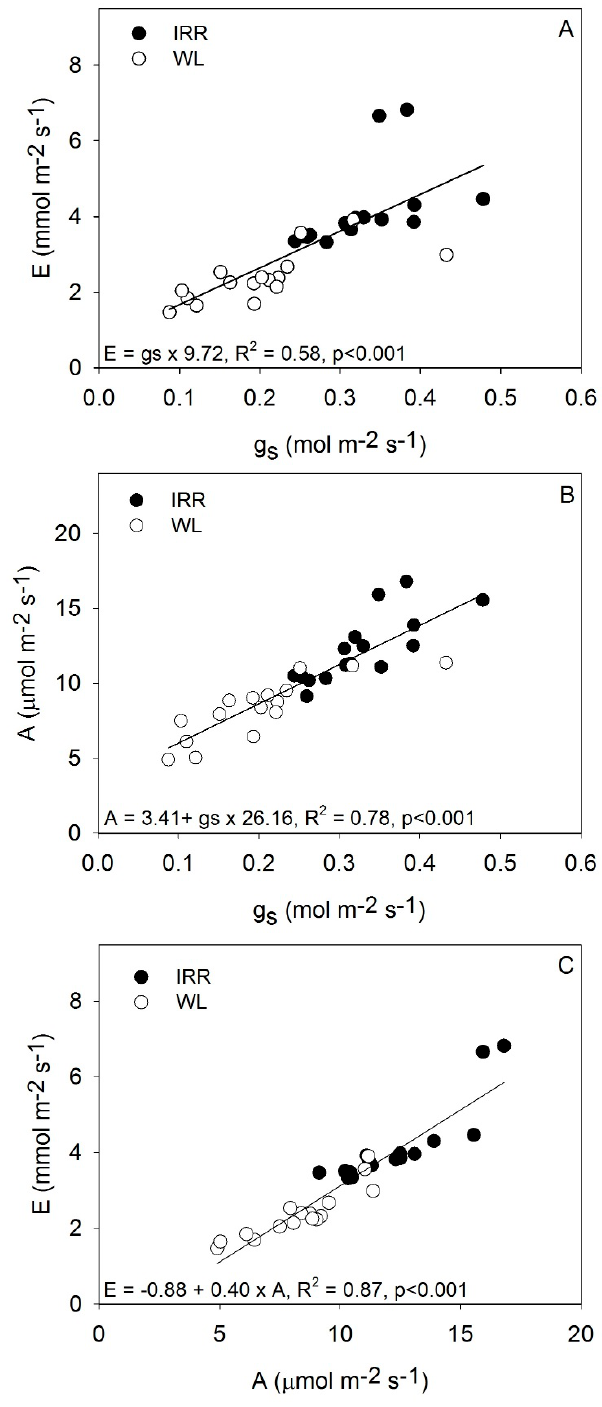
Figure 2. Relationship between stomatal conductance and transpiration ( A ); stomatal conductance and photosynthetic rate ( B ); and photosynthetic rate and transpiration ( C ) for the 16 taxa under water limited (WL) and irrigated (IRR) conditions.